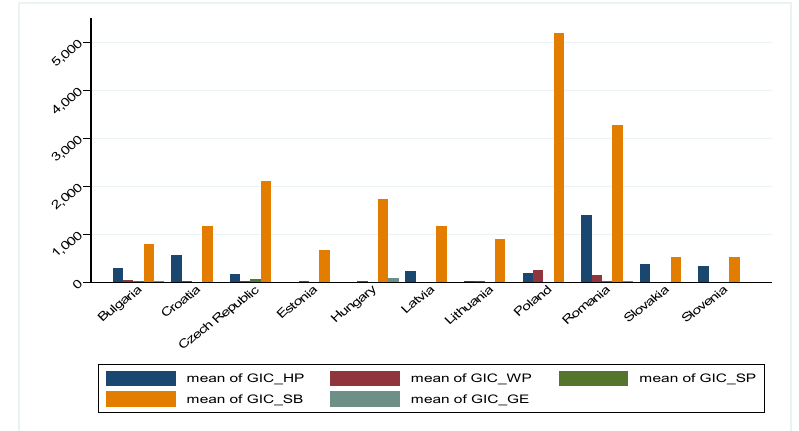
Figure 2. Mean values of gross inland consumption by form of renewable energies. Source: Authors’